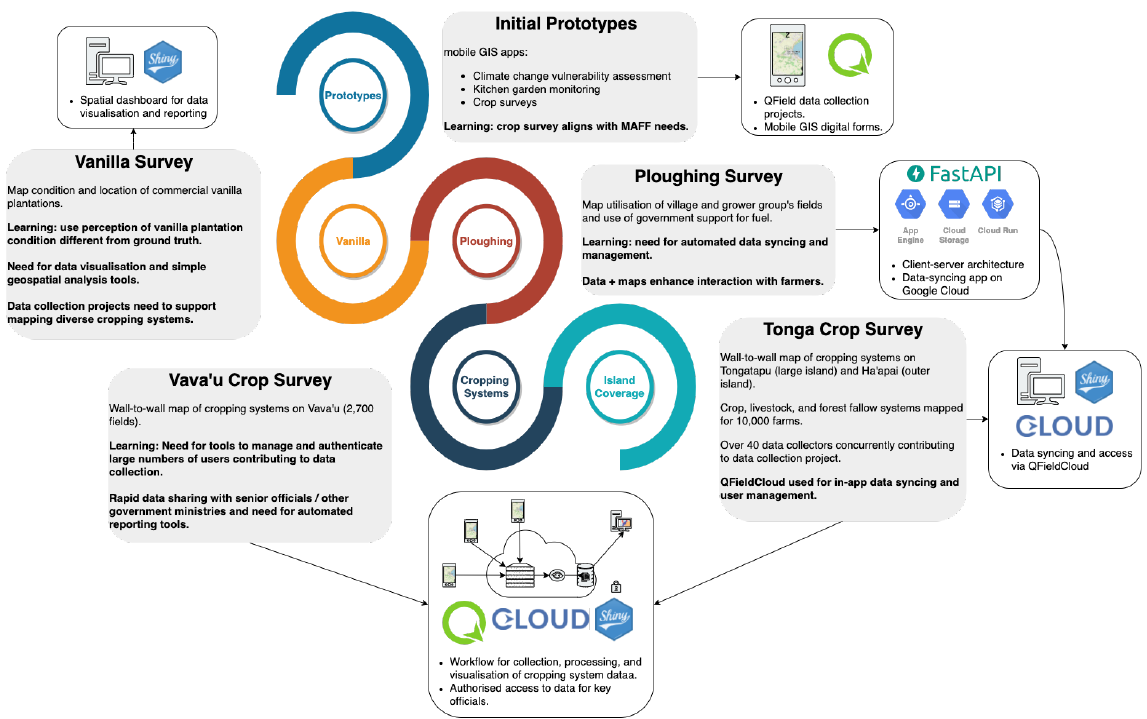
Figure 2. Main iterations of ICT system development moving from initial prototype applications, small data collection projects, to large-team data collection efforts with tools for data visualisation and reporting. . the map interface and digital forms can be created for capturing attribute and non-spatial